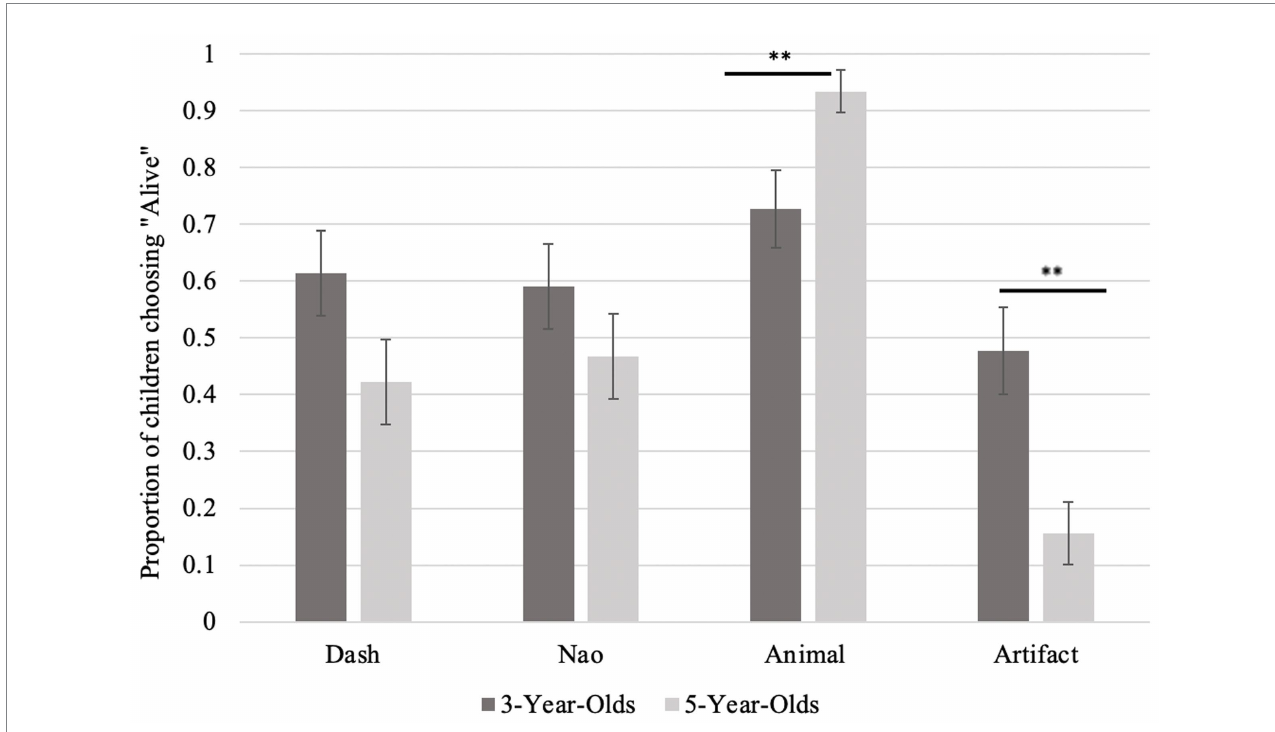
FIGURE 6 Proportion of children who rated each item as alive as a function of age. Percentage of children rating that item as alive. The ** ( p < 0.01) indicates a significant difference between the two age group on that